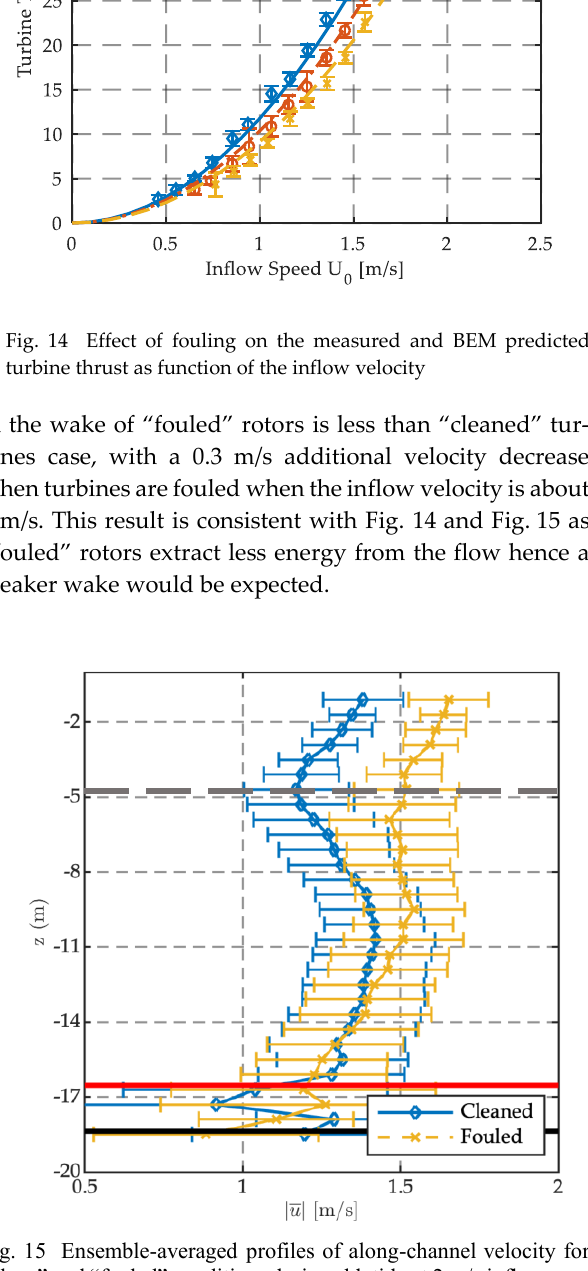
Fig. 15 Ensemble-averaged profiles of along-channel velocity for “clean” and “fouled” conditions during ebb tide at 2 m/s inflow con- ditions, five effective diameters downstream of the turbine. Error bars denote cross-wake variability (1 standard deviation). Grey dashed line denotes turbine hub-depth. Horizontal black line is the bottom. The horizontal red line indicates the depth at which side- lobe contamination from the bottom return begins to contaminate the